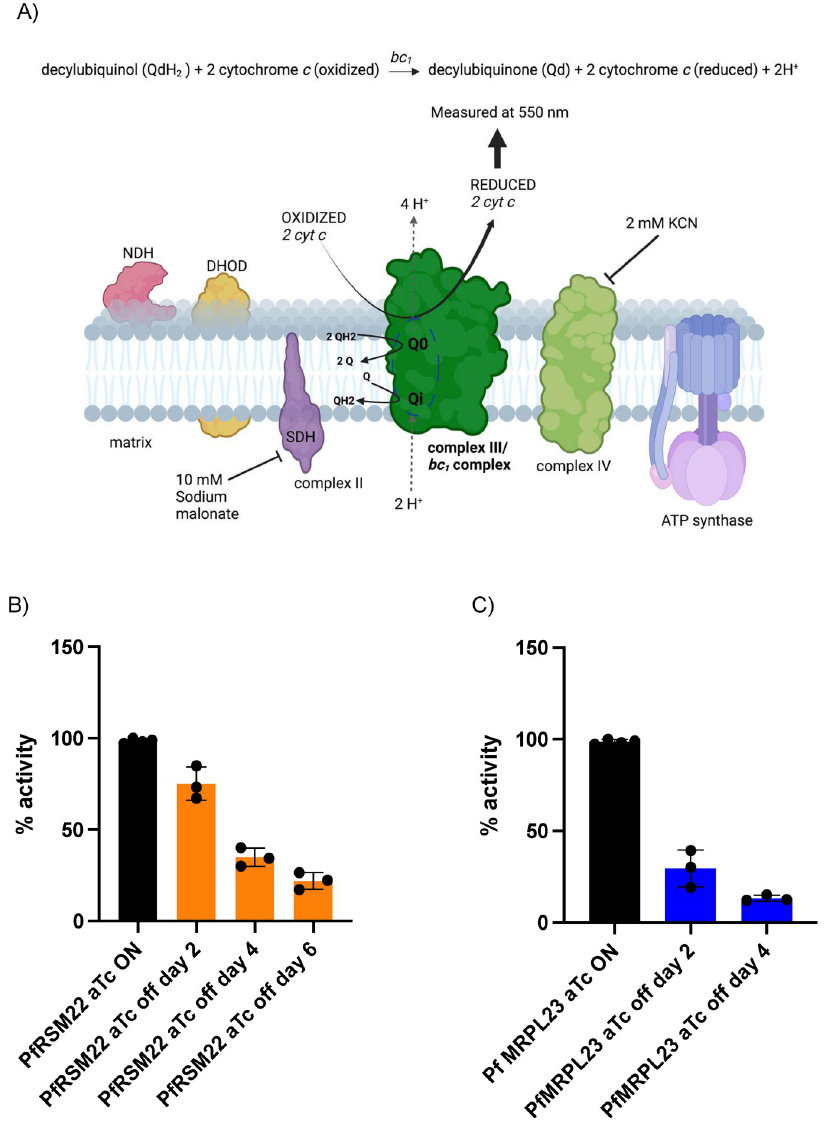
Fig 3. Reduced cytochrome bc 1 complex activity upon PfRSM22 and PfMRPL23 KD. (A) Schematic presentation of the Plasmodium mtETC. Complex III ( bc complex) activity was measured while complex II and complex IV were 1 inhibited using malonate and KCN respectively. Modified from our previous publication [10]. Created with BioRender.com. Cyt c reduction was measured at 550 nm representing functionality of bc complex in enriched and 1 solubilized mitochondria from PfRSM22 KD (B) and PfMRPL23 KD (C). The bc 1 enzymatic activity of the knockdown parasites in PfRSM22 (orange) and PfMRPL23 (blue) was normalized to their respective aTc ON controls. Kruskal- Wallis test in n = 3 experiments. ��� , p < 0.0001; �� , p < 0.001. regulated genes (p adj < 0.05) upon KD of PfRSM22 or PfMRPL23 on day 2. In PfRSM22 KD, we observed downregulation of 23 genes that belong to the broader KEGG pathway represent- ing proteasome catabolic processes, and 80 genes that belong to the KEGG pathway represent- ing ribosomes, RNA binding proteins and translation related proteins (Fig 4C, orange). The PfMRPL23 KD downregulated a wider range of KEGG pathways on day 2 including pentose phosphate pathway, RNA degradation and spliceosome proteins, along with the ribosomal biogenesis pathway (Fig 4C, blue). Among the upregulated pathways on day 2, on the other